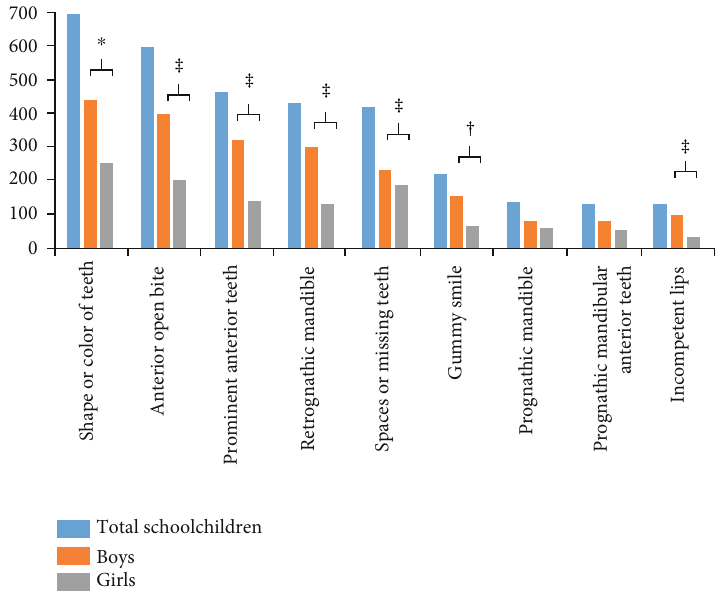
Figure 3: Frequency distribution of dentofacial features reported as targets for victimization according to gender. a ∗ p < 0 : 05 , † p < 0 : 01 , and ‡ p < 0 : 001 .